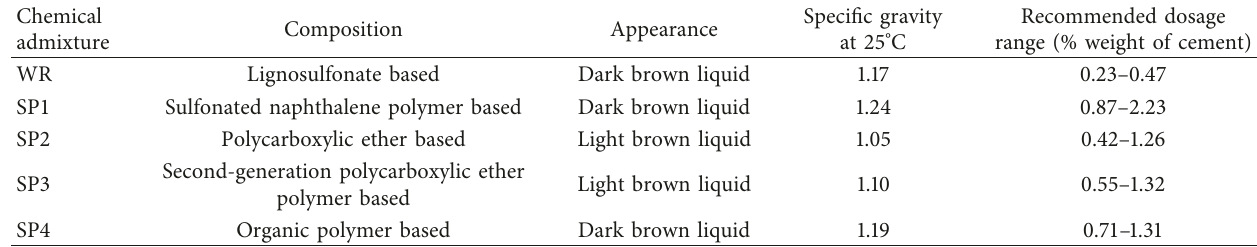
Table 1: Properties and recommended ranges of dosage of chemical